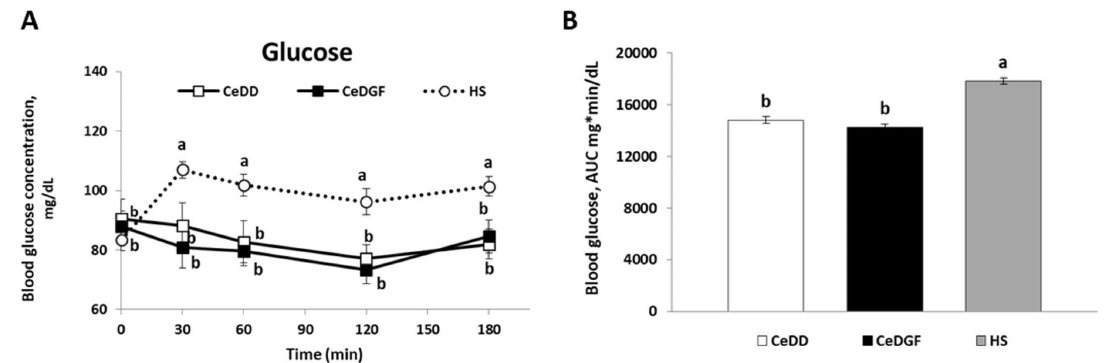
Figure 3. Post-prandial blood glucose. ( A ) The concentration-time response over three hours post-meal consumption in subjects with CeD at diagnosis (CeDD), on a GFD (CeDGF) and in healthy subjects (HS); ( B ) AUC of blood glucose over three hours post-meal in the three groups of subjects. Different letters on blood glucose concentration lines indicate significant differences between times and groups; different letters on AUC bars indicate significant differences between groups (ANOVA and post-hoc Tukey test, p <